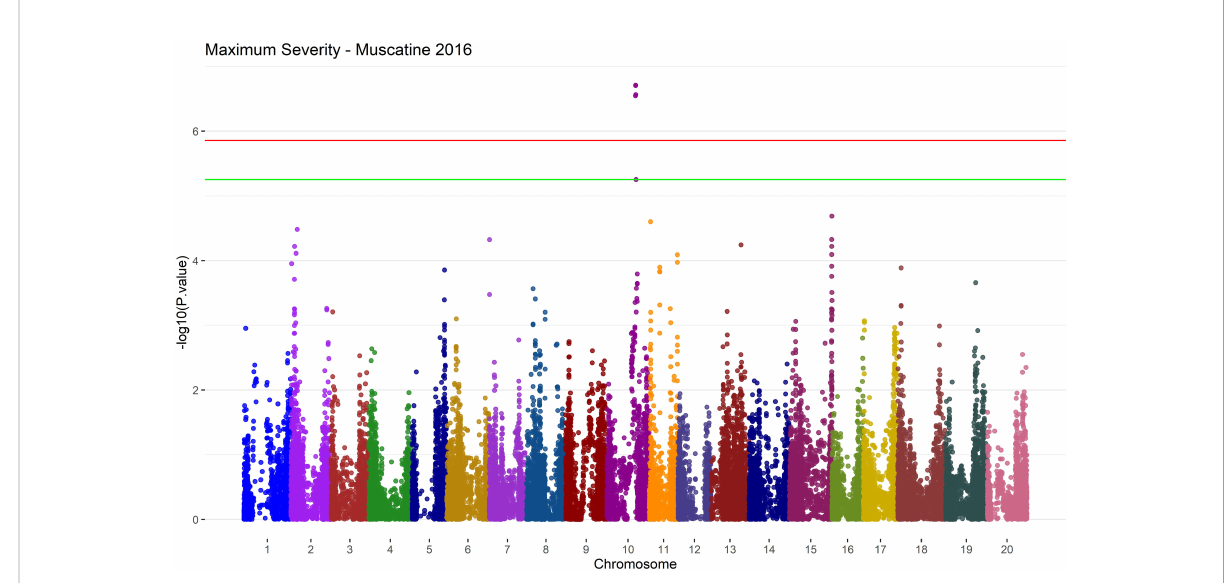
FIGURE 9 Manhattan plot of results from MLM in GAPIT version 3 for the Maximum Severity trait in Muscatine 2016 using a MAF of 5%. The negative log base 10 transformed p values are plotted against their position along each of the 20 chromosomes. The green line represents the FDR correction threshold and the red line represents the Bonferroni correction threshold. Signi fi cant SNPs can be denoted by exceeding the FDR correction threshold. In this environment/trait combination, run with the MLM model on GAPIT version 3, there is 5 signi fi cant SNPs on chromosome